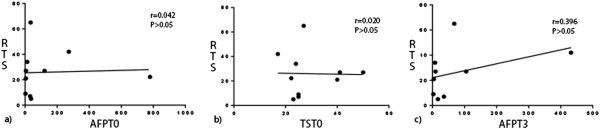
Correlations between studied variables and recurrent tumor size in patients who underwent RFA. (a) Pre-treatment serum AFP level (AFPT0) and recurrent tumor size (RTS) were not correlated (r = 0.042, P > 0.05). (b) Recurrent tumor size (TST0) and RTS were not correlated (r = 0.020, P > 0.05). (c) The 3-month post-treatment serum level (AFTT3) and RTS were not correlated (r = 0.396, P > 0.05).